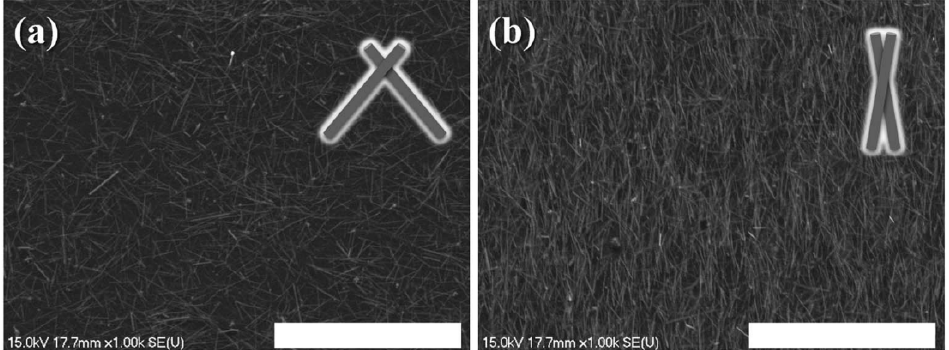
Figure 1. SEM image of final mesh heater before ( a ) and after ( b ) biaxial stretching of serpentine structure; stretching rate 100% (scale bars: 50 µ m). Reprinted with permission from [52]. Copyright 2016 RSC